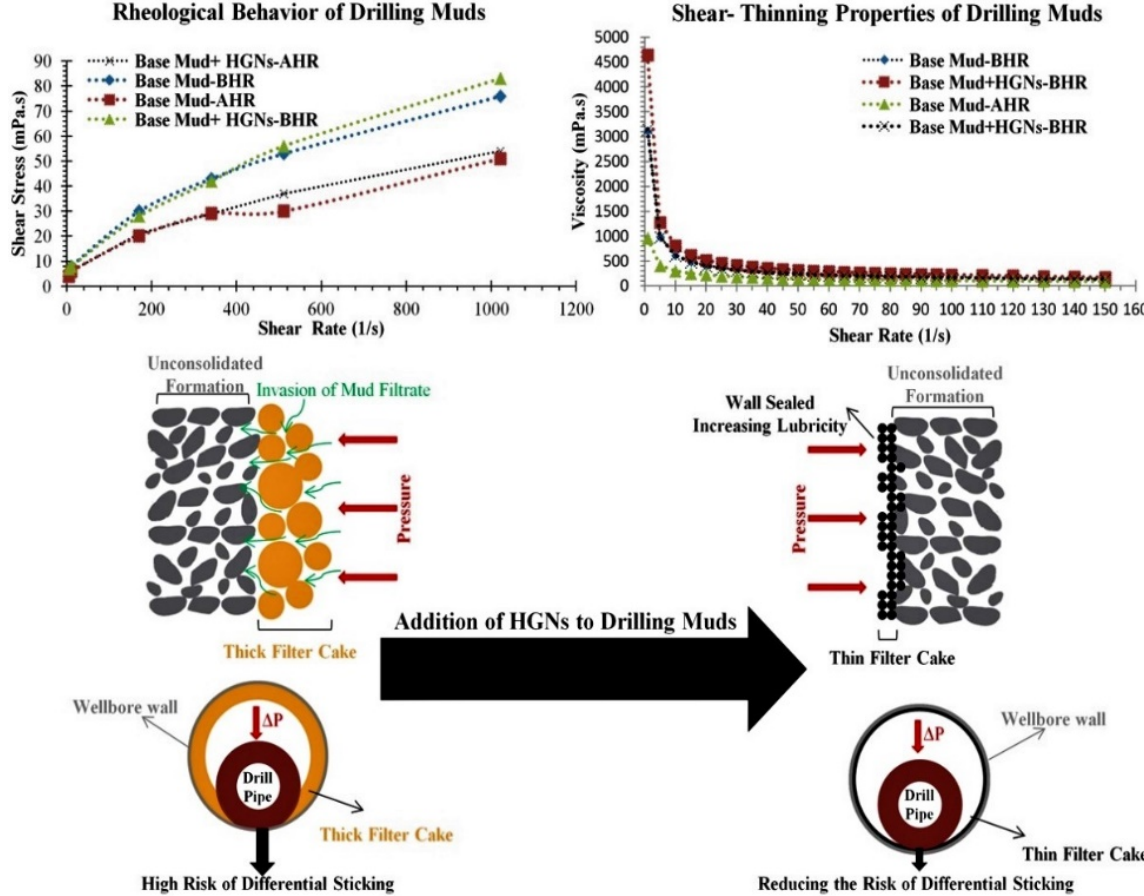
Figure 12. Lubricity characteristics of drilling fluids using hydrophilic gilsonite nanoparticles (HGNs) for rheological properties and assessment of the sticking of the base fluids [139].